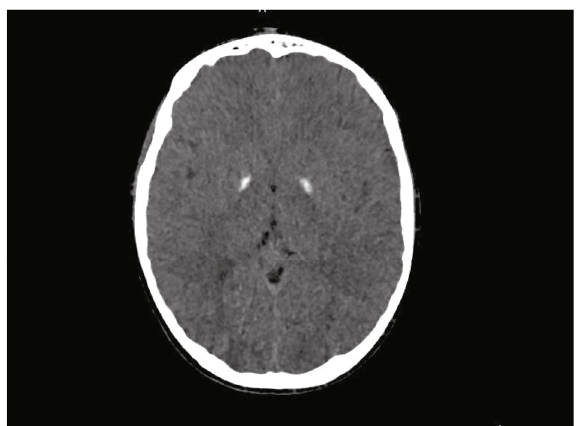
Figure 1: Axial CT scan showing bilateral calci fi cations of the globus pallidus.